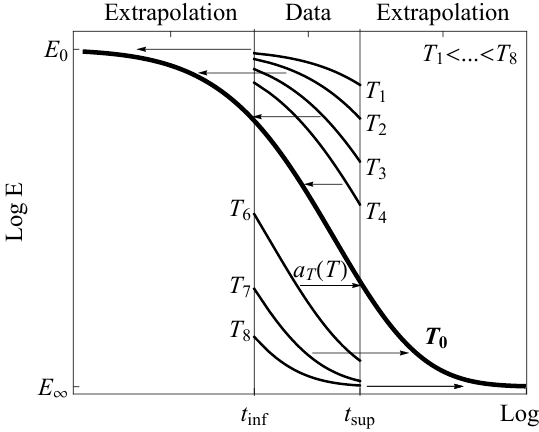
Figure 1. Scheme of the Time–Temperature Superposition (TTS) principle for the building master curve from short-time tests at different